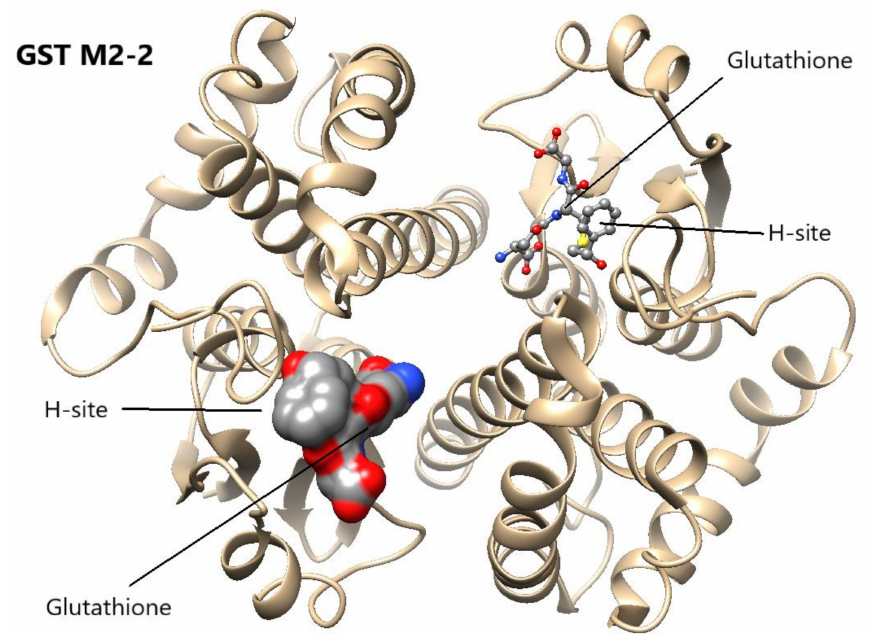
Figure 1. Human GST M2-2 showing location of the G-site and the H-site in each subunit. A structure of the enzyme in complex with aminochrome or its glutathione conjugate is not available, but the location of glutathione (G-site) and the H-site can be identified by the bound glutathione conjugate of S-styrene 7,8-oxide (shown left in space-filling and right in ball-and-stick representations). The figure is based on the crystal structure (PDB ID: 2C4J) and rendered in UCSF Chimera